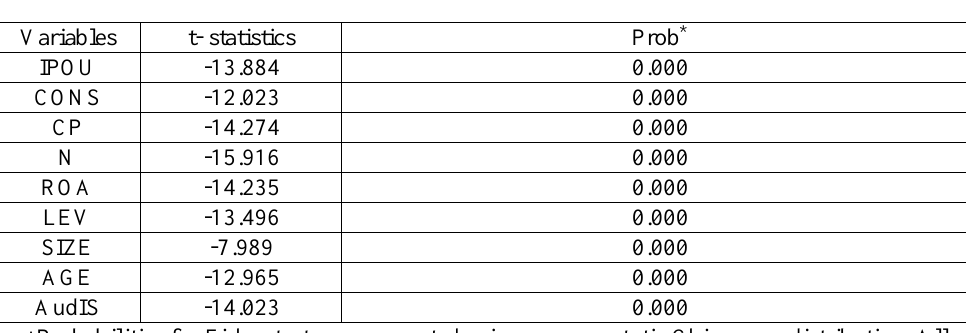
*Probabilities for Fisher tests are computed using an asymptotic Chi-square distribution. All other tests assume asymptotic